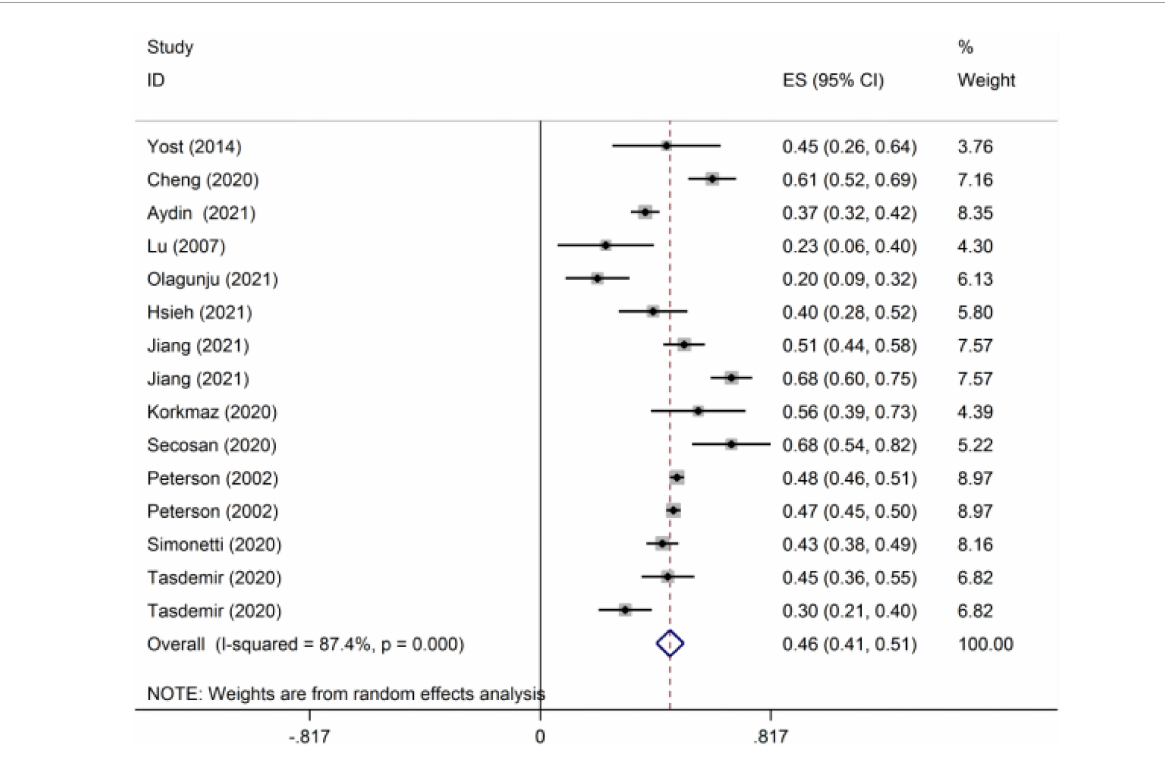
FIGURE2 The meta-analytic estimates of the correlation coefficient (r)*. *The data were integrated as Fisher’s Z